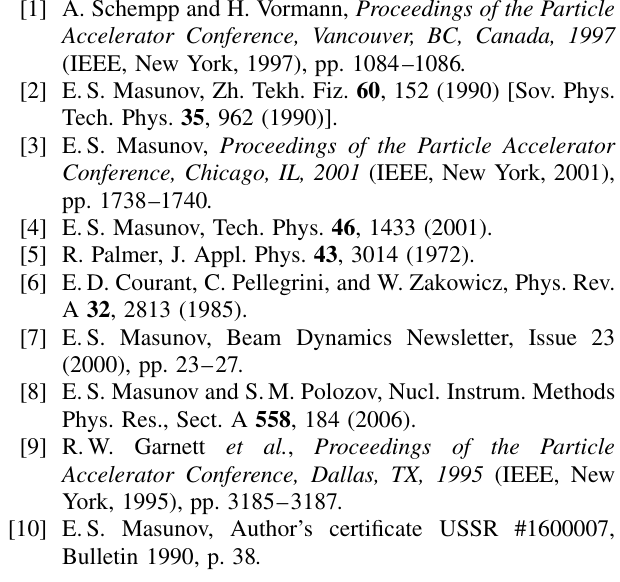
FIG. 10. (Color) The current transmission coefficient when j I (cid:2)(cid:5)(cid:3) j (cid:1) j I (cid:2)(cid:7)(cid:3) j , j I (cid:2)(cid:5)(cid:3) j (cid:1) 0 : 3 A (a) and j I (cid:2)(cid:5)(cid:3) j (cid:1) 0 : 5 A